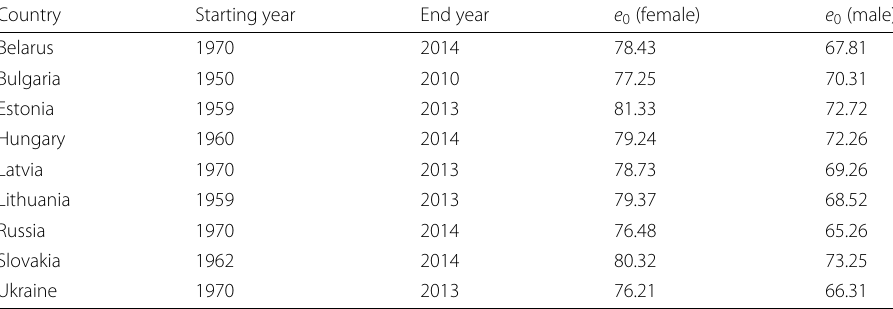
Table 1 Fitting periods for the countries and life expectancy at birth (HMD 2018)